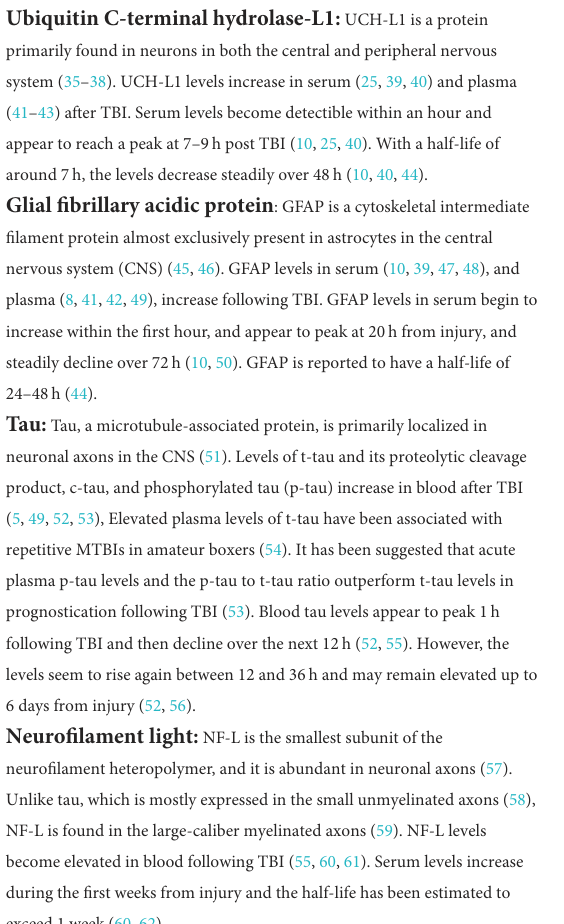
midline shift, cisternal compression, fourth ventricle